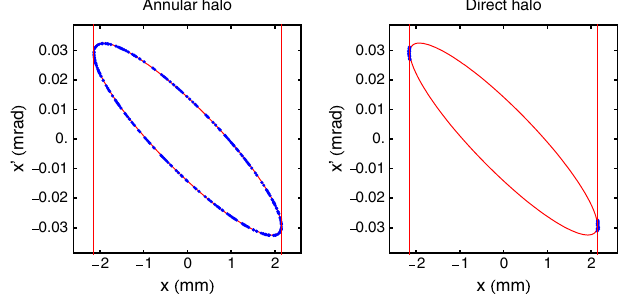
FIG. 4. Examples of the horizontal phase space of the starting distributions at the TCP for annular halo (left) and direct halo (right). Each blue point represents a single particle, and the red ellipse the matched 5.7 σ envelope. The vertical red lines represent the cuts of the TCP